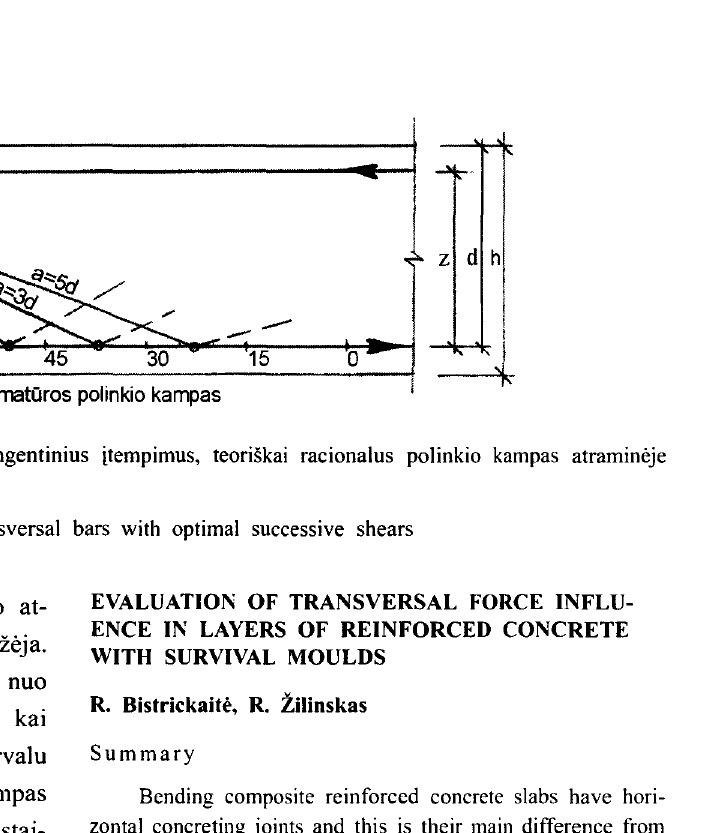
3. Didejant koncentruotosios jegos pridejimo at stumui, tangentiniq itempimq polinkio kampas